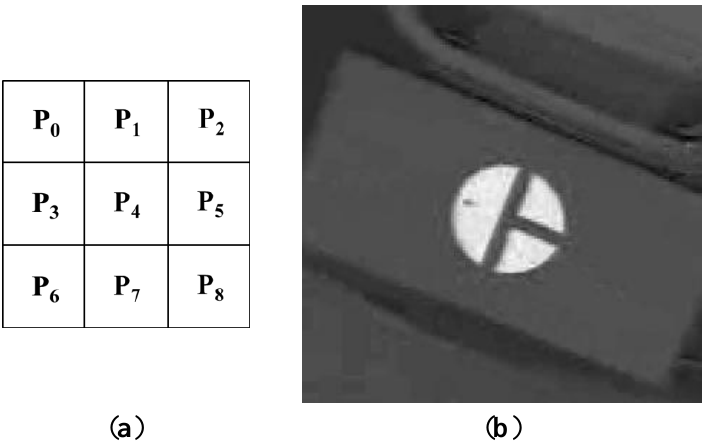
Figure 8. Sub-block difference-based matching using 3 × 3 sub-block mask. ( a ) 3 × 3 Sub-block mask; ( b ) Detected marker position using 3 × 3 sub-block